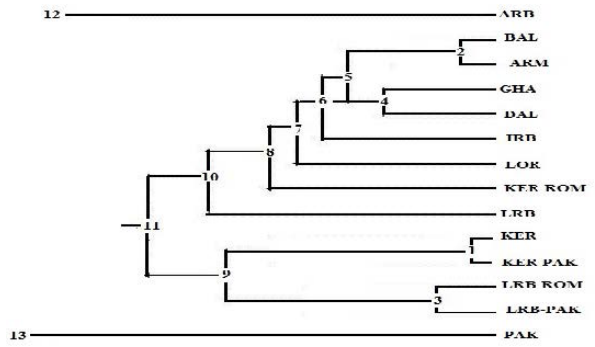
Figure 1. UPGMA phylogenetic tree based on Nei genetic distance. Location of these 14 studied breeds is shown in Fig. 2. Subspecies are indicated as Kermani (KER), Pakistani (PAK), Lori (LOR),